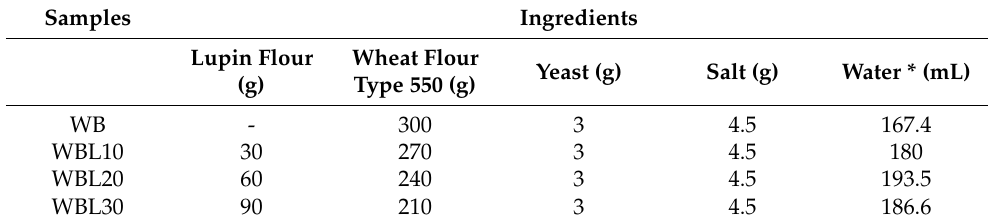
Table 1. Recipes for composite lupin